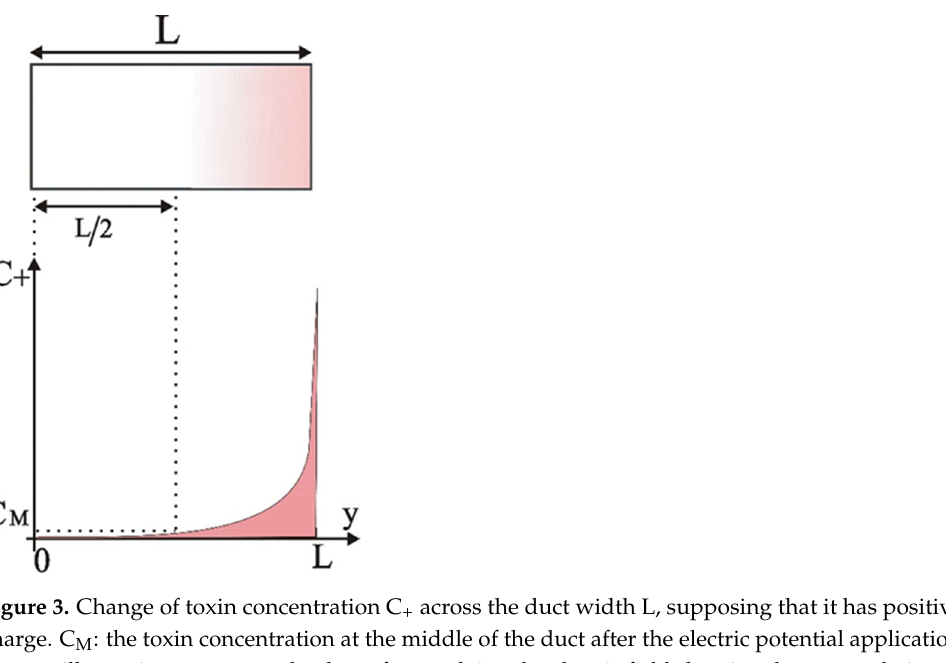
The top illustration represents the duct after applying the electric field showing the accumulation of charged toxins on one side of it.